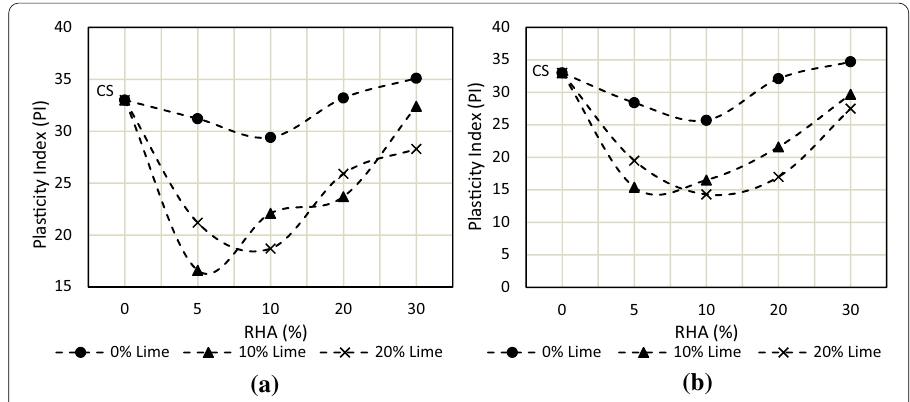
Fig. 2 Variation of plasticity index with RHA and lime content a Soon after mixing b 28 days after